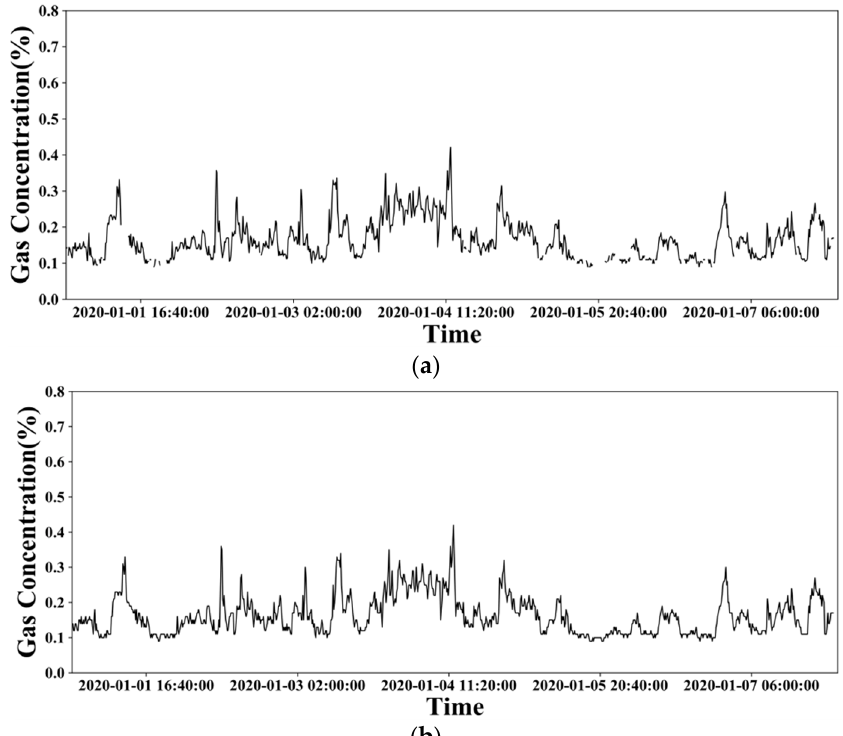
Figure 2. The gas concentration variation trend of a monitoring point within a week before ( a ) and after ( b ) missing data imputation.